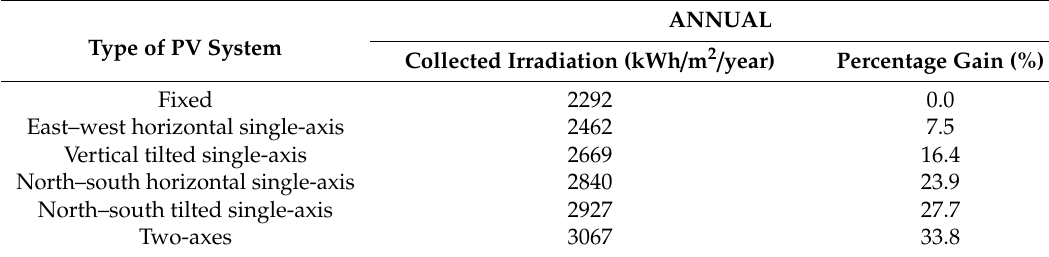
Figure 3. Monthly behavior of the different types of sun trackers in Aguascalientes, and comparison to a south-oriented fixed structure system with tilt equal to latitude. Table 2. Annual collected irradiation and percentage gains relative to a south-oriented fixed structure system with tilt equal to latitude of the different types of sun trackers in Aguascalientes.